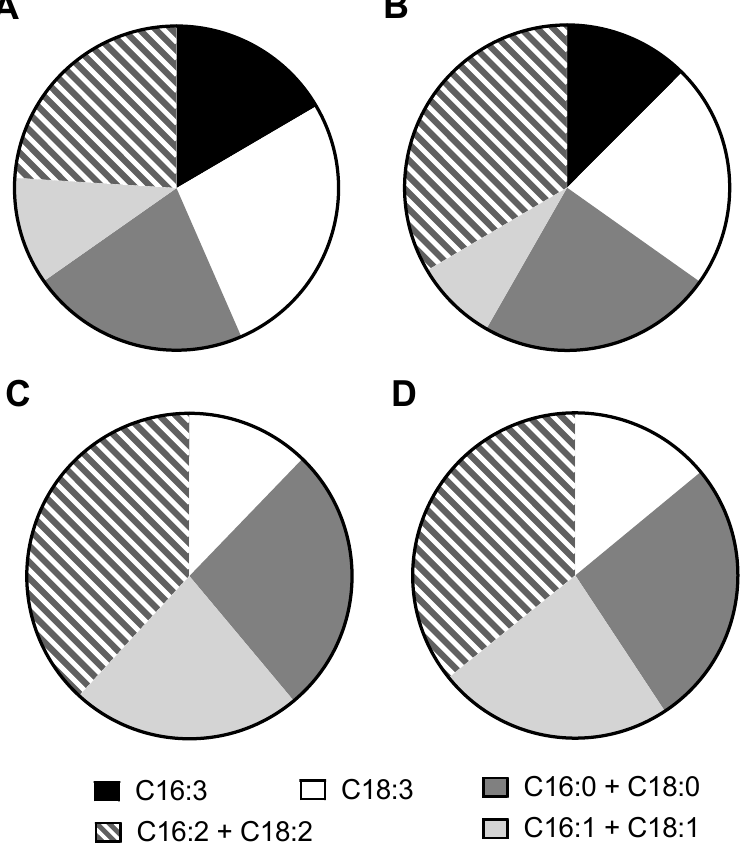
Figure 5. Changes in the fatty acids of C. sorokiniana at different growth phases under mixotrophic and heterotrophic conditions. Fatty acids were analyzed from this and a previous study: ( A ) mixotrophic cells at the exponential phase (this study); ( B ) heterotrophic cells at the exponential phase (this study); ( C ) mixotrophic cells at the stationary phase (Li et al., 2014); ( D ) heterotrophic cells at the stationary phase (Li et al., 2014).